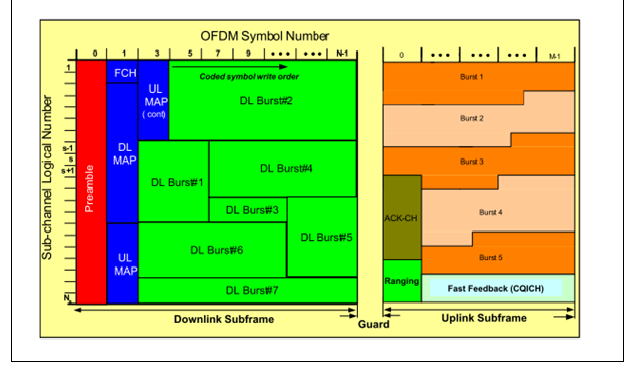
Figure 6. Comparison of Sub-channelization Mechanism - a) Distributed (PUSC) and b) Adjacent (AMC)